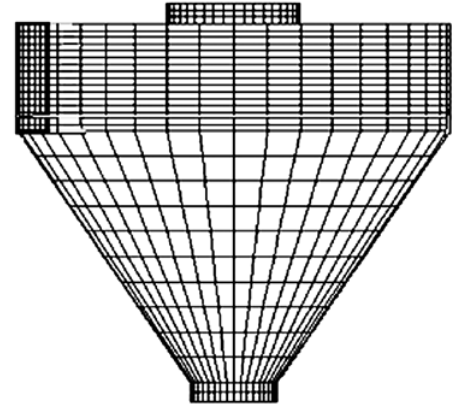
Fig. 2. Multi-channel cyclone computing grid sketch: inlet (at the top of cylinder, inlet area a × b= 28 × 95 mm); two outlets – at the bottom, for solid particles and a pipe with diameter R = 0.0245